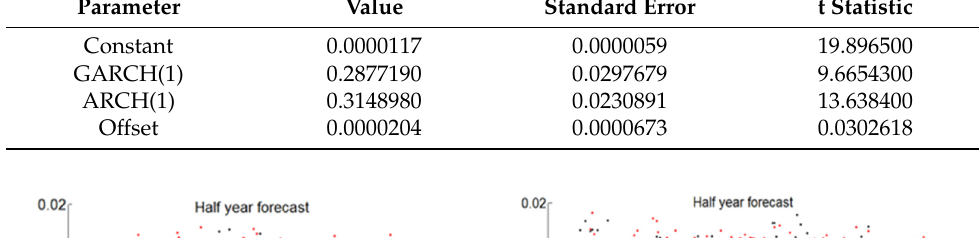
Table 8. GARCH (1,1) model parameters of lhaz residual sequence. Parameter Value